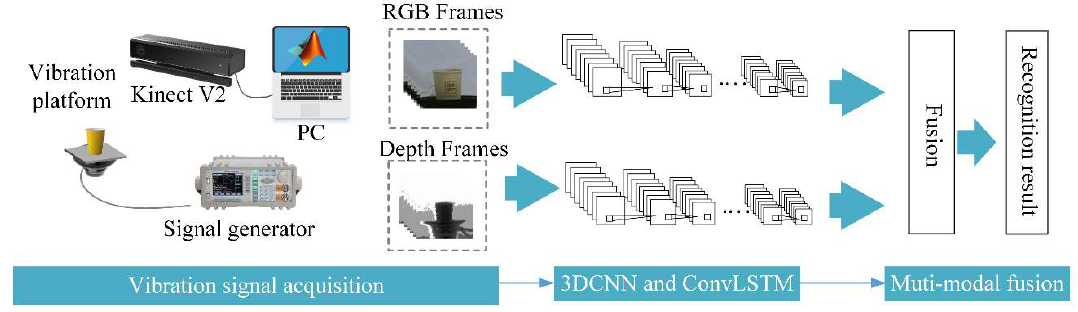
Figure 1. Flowchart of the proposed method.